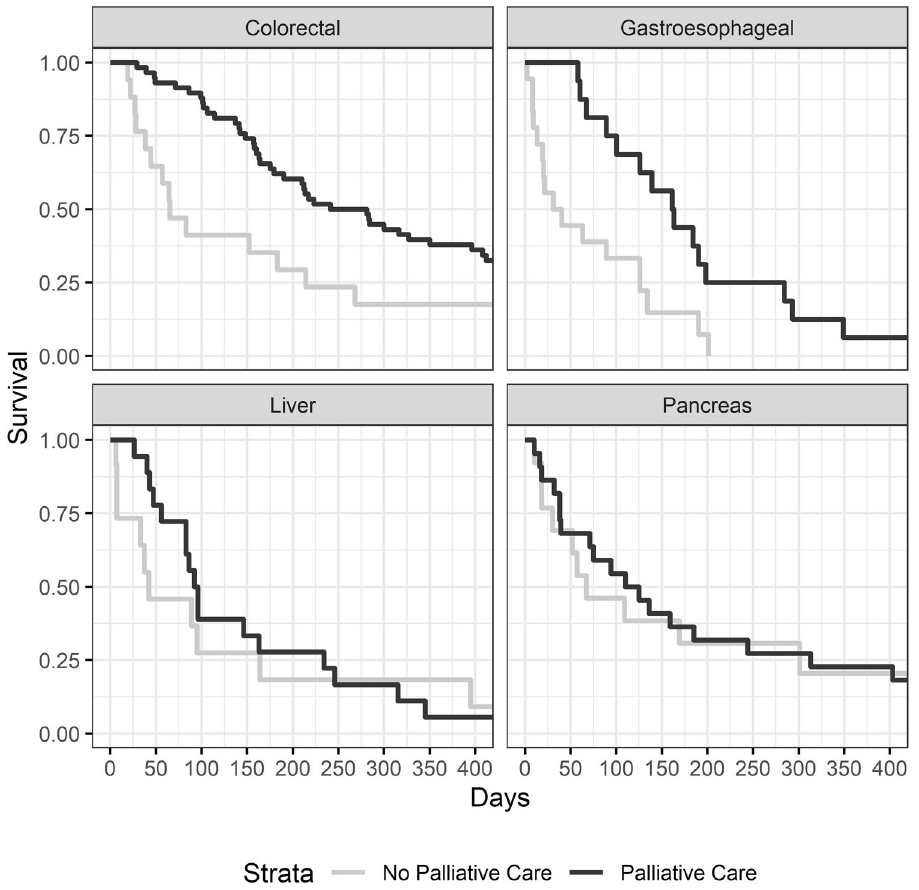
Figure 2. Kaplan Meier survival curves for patients with metastatic hepatopancreaticobiliary and gastrointestinal cancers referred to palliative care services at a single institution, 2014–2018, by primary tumor site.